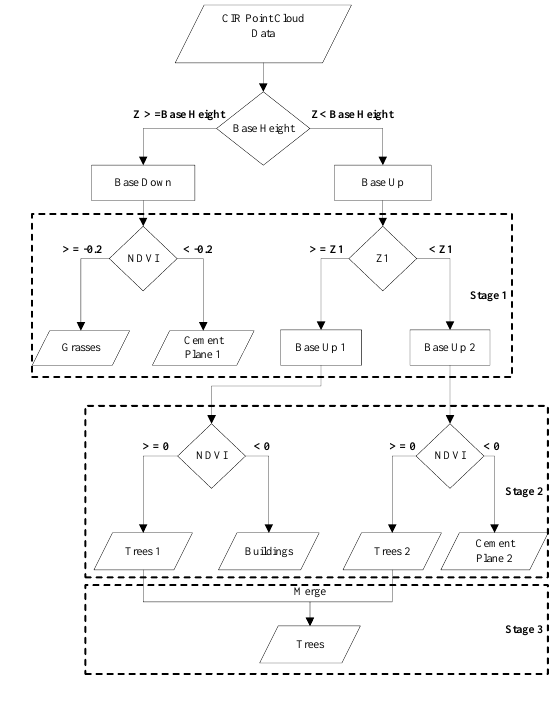
Figure 6. Classification flow chart